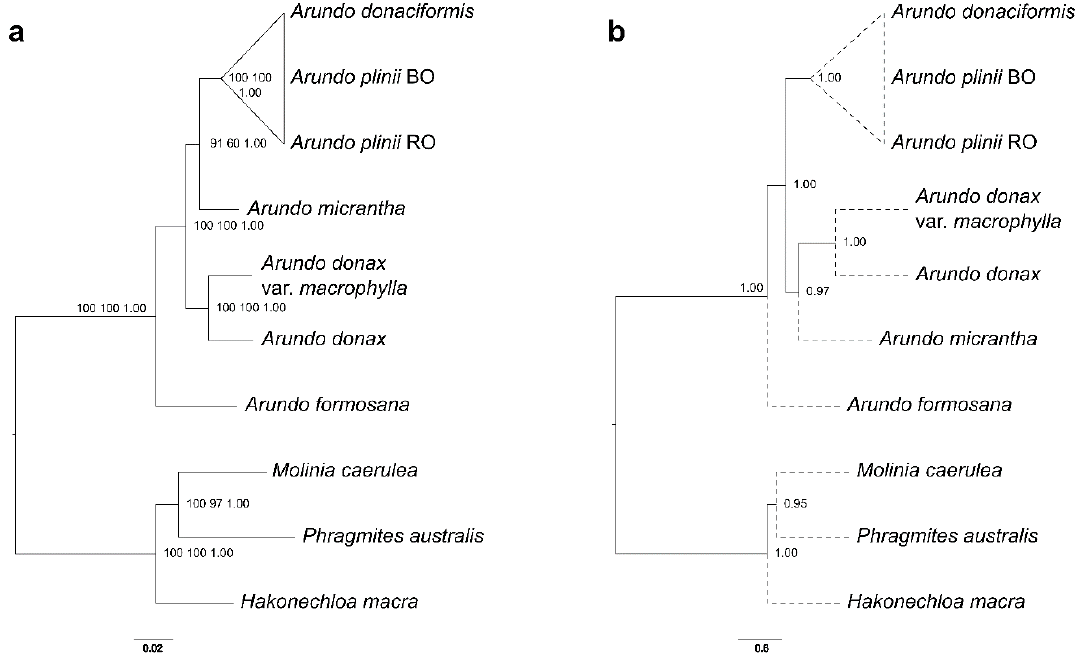
Figure 1. Species tree reconstructions of the Arundo genus from the dataset of 144 nuclear genes. ( a ) maximum likelihood (ML) topology of the species tree performed by IQ-TREE using the edge-linked optimal partition scheme of the gene supermatrix. Numbers are ML ultrafast bootstrap (percentage), maximum parsimony (MP) non parametric bootstrap (percentage) and posterior probability (fraction) support values. ( b ) Coalescent reconstruction of the species tree performed by ASTRAL III using the supertree approach on the ML trees of each gene. Dotted lines represent topological connections as ASTRAL does not estimate branch lengths for terminal branches. Numbers are local posterior probabilities for the main quartet topology.